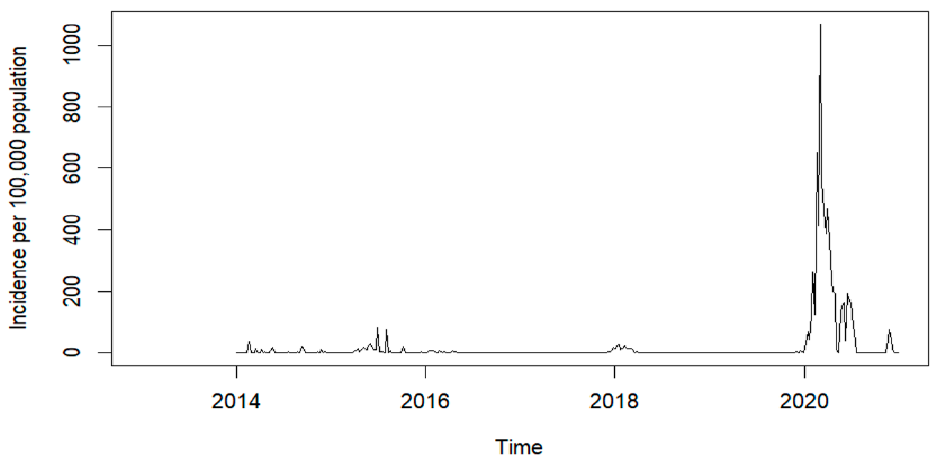
Figure 1. Total number of cases per year from 2014 to 2020 in Asuncion, Paraguay. Table 1. Summary statistics of weekly dengue fever data from 2014 to 2020 in Asuncion, Para- guay.